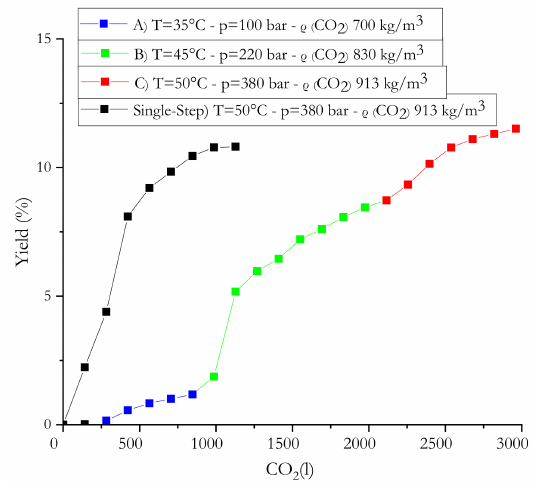
Figure 1. Extraction kinetics in single-step and sequential sc-CO 2 extractions from Cp